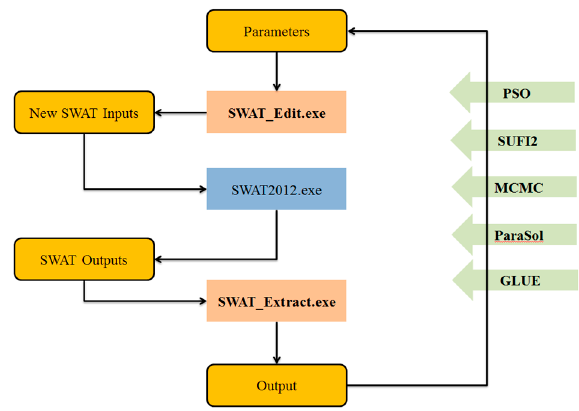
Figure 5. Soil and water assessment tool calibration and uncertainty programs (SWAT-CUP) model structure (PSO: Parameter Solutions; SUFI2: Sequential Uncertainty Fitting; MCMC: Markov Chain Monte Carlo; PraSol: Particle Swarm Optimization; GLUE: Generalized Likelihood Estimation).